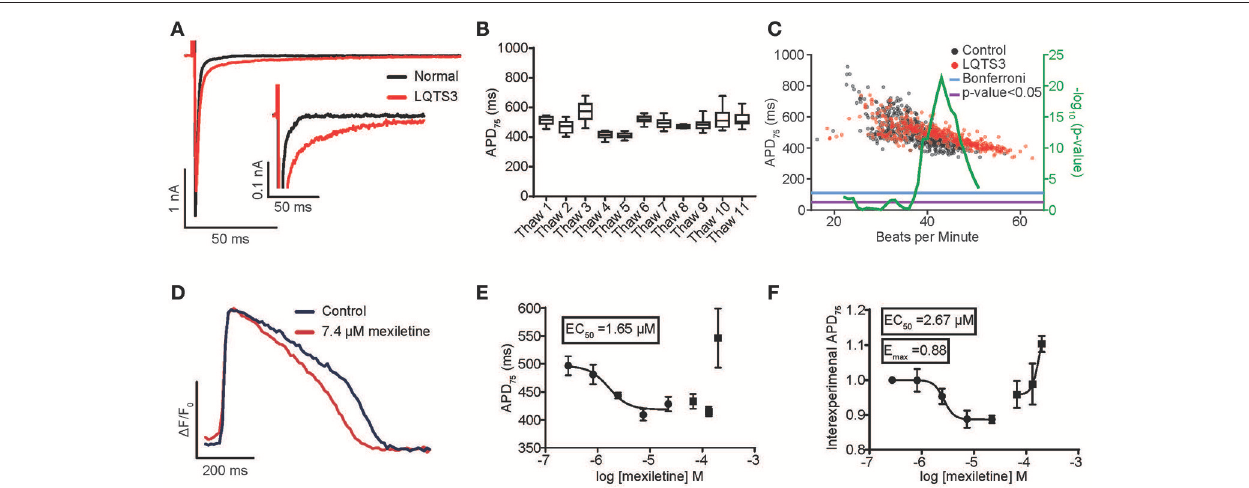
FIGURE 4 | Reversion of congenital long QT syndrome type 3 in hiPSC-CMs. (A) Sodium current recording from an LQTS3 (F1473C) hiPSC-CM (red trace) exhibiting increase late sodium current in response to a 150 ms voltage step from –80 to –40 mV as compared to a normal individual (iCell) hiPSC-CM (black trace). I NaL was 1.2% ± 0.604 of I NaP in the LQTS3 hiPSC-CMs for n = 10. There was no detectable late current in the normal hiPSC-CMs. (B) Average APD 75 from controls wells for all LQTS3 hiPSC-CM experiments plotted for multiple thaws of the same lot. (C) Plot of Average APD 75 vs. BPM from individual LQTS3 and normal cardiomyocyte wells. Mann-Whitney test using a sliding window (center value ± 3) (green) with Mann-Whitney p < 0.05 (purple) and Bonferroni corrected p -value (blue). (D) An average normalized 1 F/F 0 vs. time plot (100Hz) from all peaks each well ( n = 3) either untreated or with treated 7.4 µ M mexiletine in LQTS3 hiPSC-CMs. Scale bars indicate time (200 ms) and 1 F/F 0 (50% of the maximal obtained in each well). (E) A dose response curve for APD 75 for a single experiment with LQTS3 hiPSC-CMs. EC 50 value is 1.65 µ M. Each point represents an individual well, n = 3. Error bars are s.e.m. (F) A dose response curve from multiple thaws of LQTS3 hiPSC-CMs ( n = 4). Each point represents the average ± s.e.m for n = 4 separate experiments of the normalized change in APD 75 for each dose of mexiletine from all experiments.